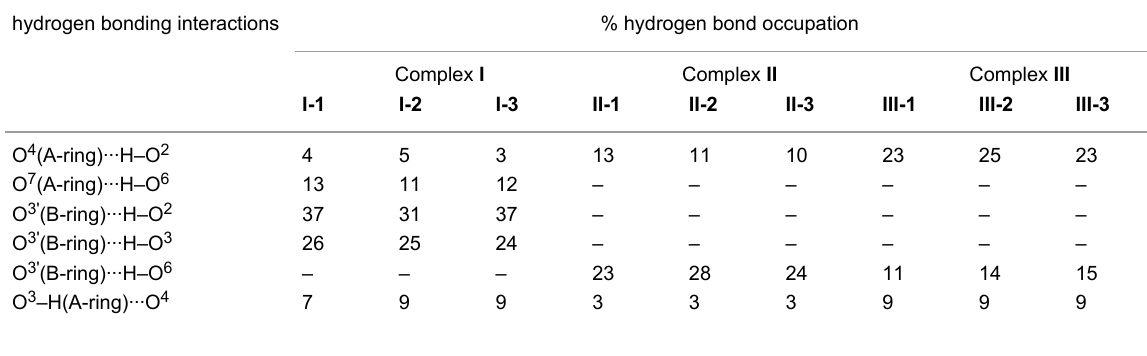
Table 3: Percentage of hydrogen bond occupations for the nine systems of the fisetin/ β -CD complexes. hydrogen bonding